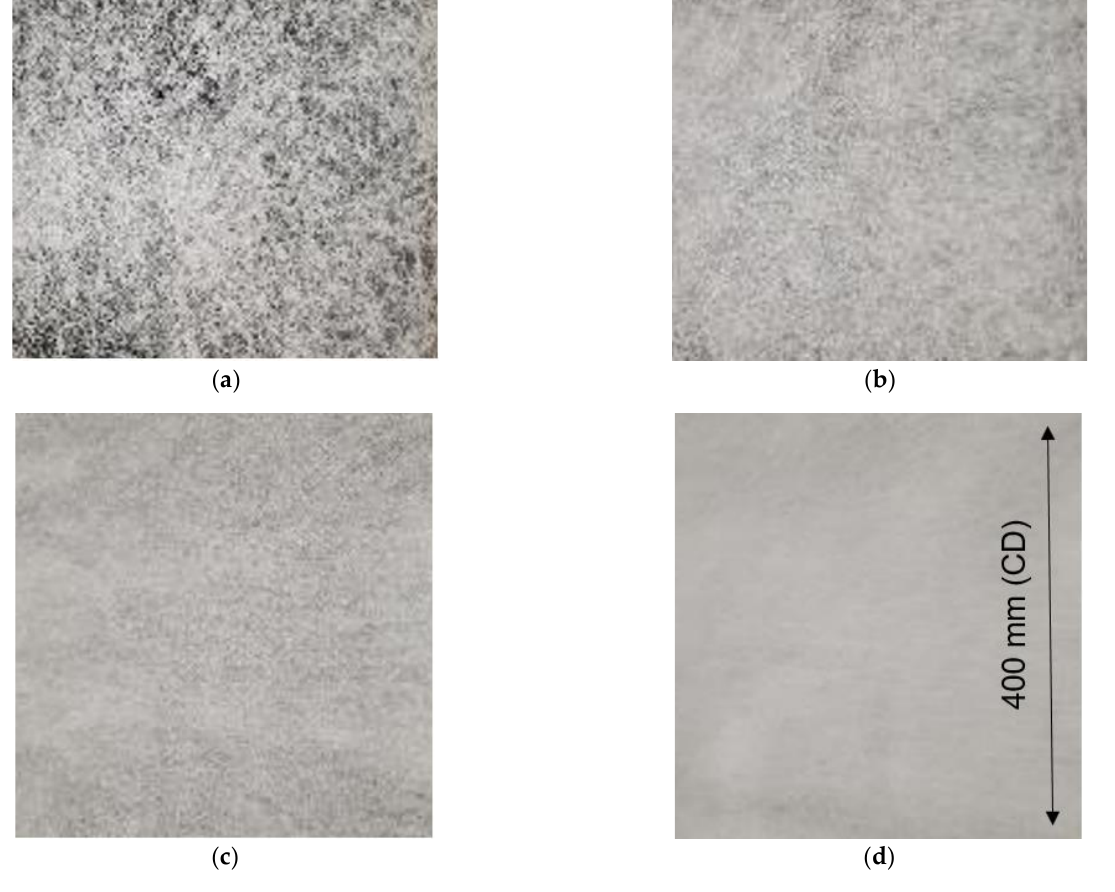
Figure 8. Fabrics of PP with decreasing average fiber diameter: ( a ) MD = 25 μm; ( b ) MD = 10 μm; ( c ) MD = 5 μm; ( d ) MD = 3 μm.